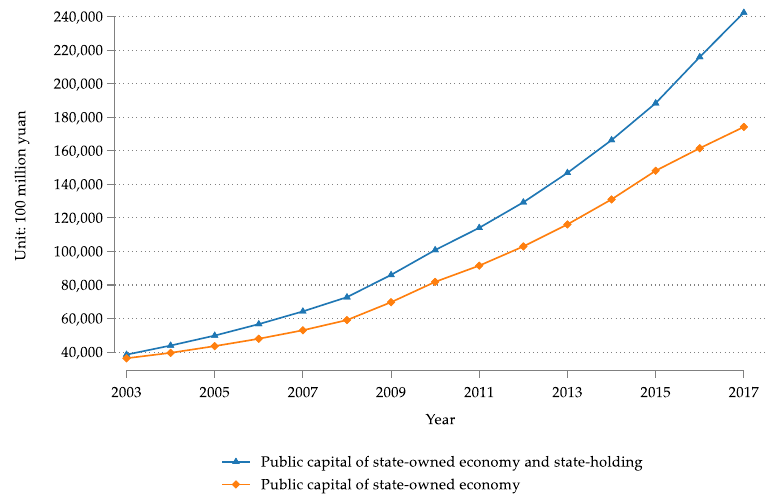
Figure 4. Public capital inventory of different investment sequences in 2003 – 2017.